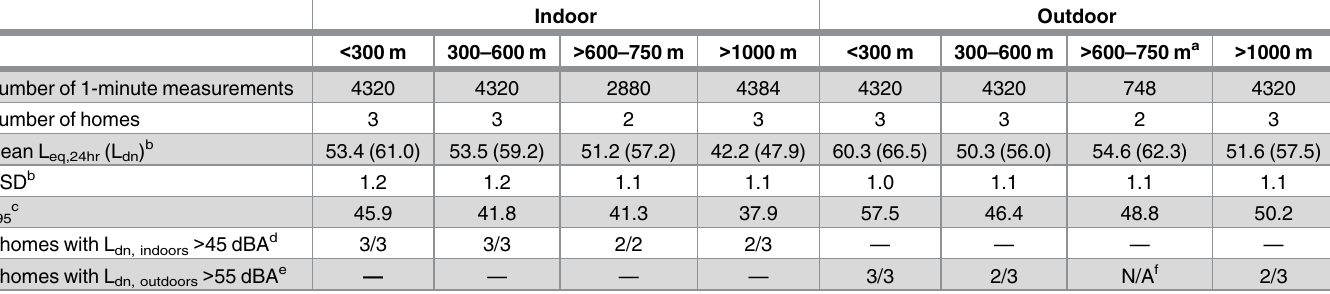
Table 1. Summarystatistics for 24-hour A-weighted noise levels (dBA) by proximity to nearestcompressorstation stratified by location within home (indoors vs. outdoors). Indoor Outdoor < 300 m 300–600 m > 600–750m > 1000 m < 300 m 300–600 m > 600–750m a > 1000 m Number of 1-minute measurements